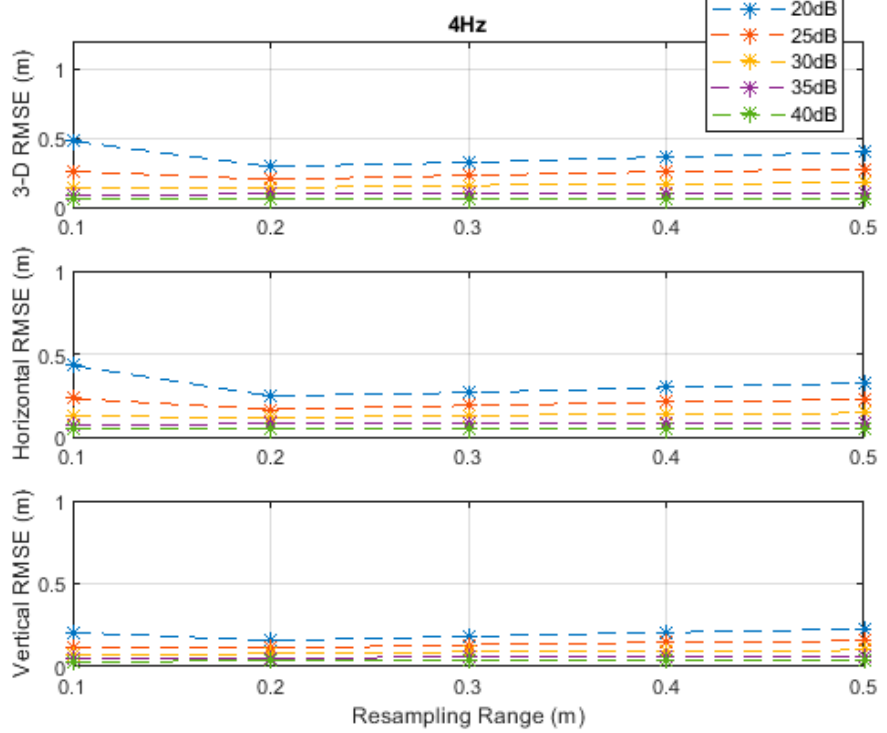
Figure 10. RMSE results along the horizontal circular path at a measurement update rate of 2 Hz.